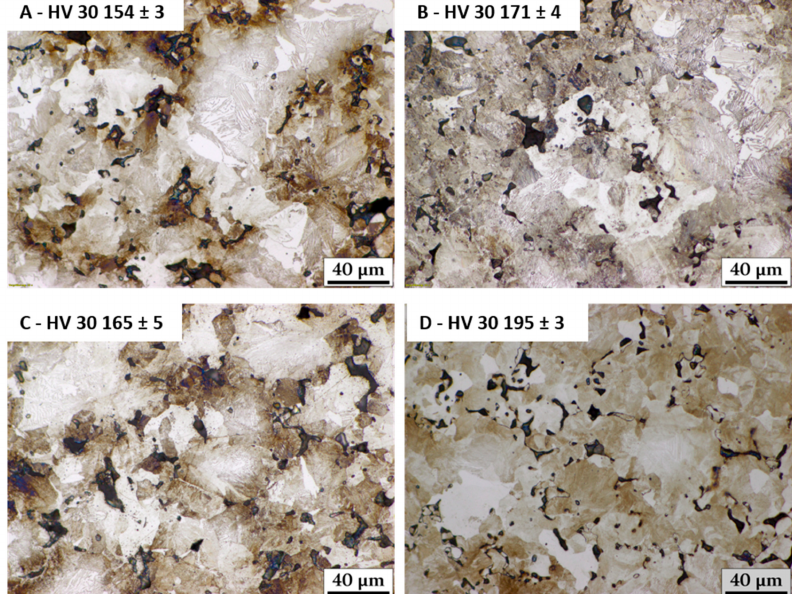
Figure 8. Metallographic sections of samples heated at 10 K/min to 1180 ◦ C in a pusher furnace and cooled in a water- jacketed exit zone (~0.5 K/s). (A) ASC + 4%CrMA1_0.6C nom (0.55C comb ) HV 0.1 211 ± 25, (B) ASC + 4%CrMA1_0.75C (0.64C) HV 0.1 240 ± 40, (C) ASC + 4%CrMA2_0.6C (0.54C) HV 0.1 230 ± 33, (D) ASC + 4%CrMA2_0.75C (0.67C) HV 0.1 265 ± 14.